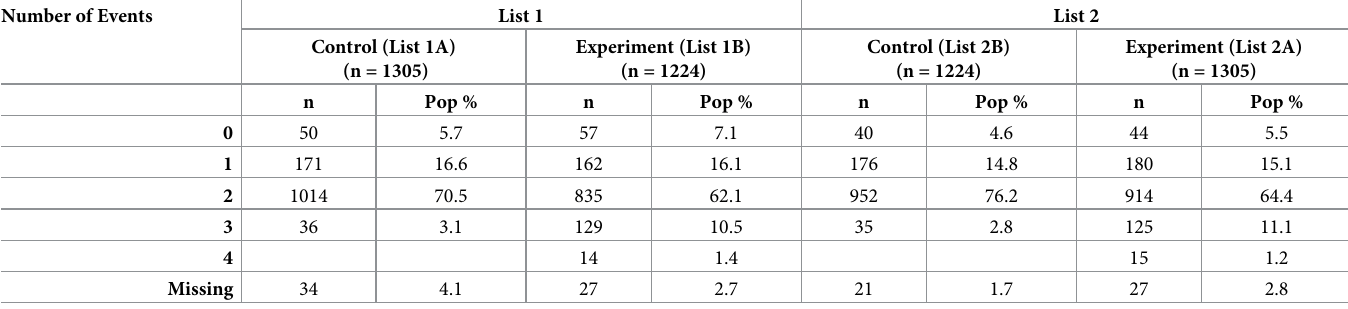
Table 2. Number of events selected by respondents between and across lists of the indirect measure of abortion utilization in the Ohio Survey of Women (n = 2529). Number of Events List